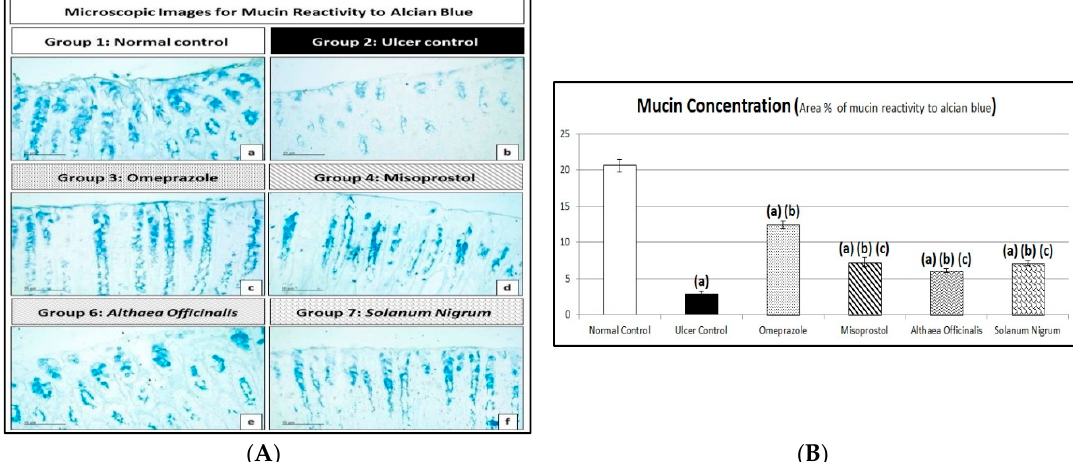
Figure 5. ( A ) Photomicrographs (50 µm magnification) of each group of gastric mucosa